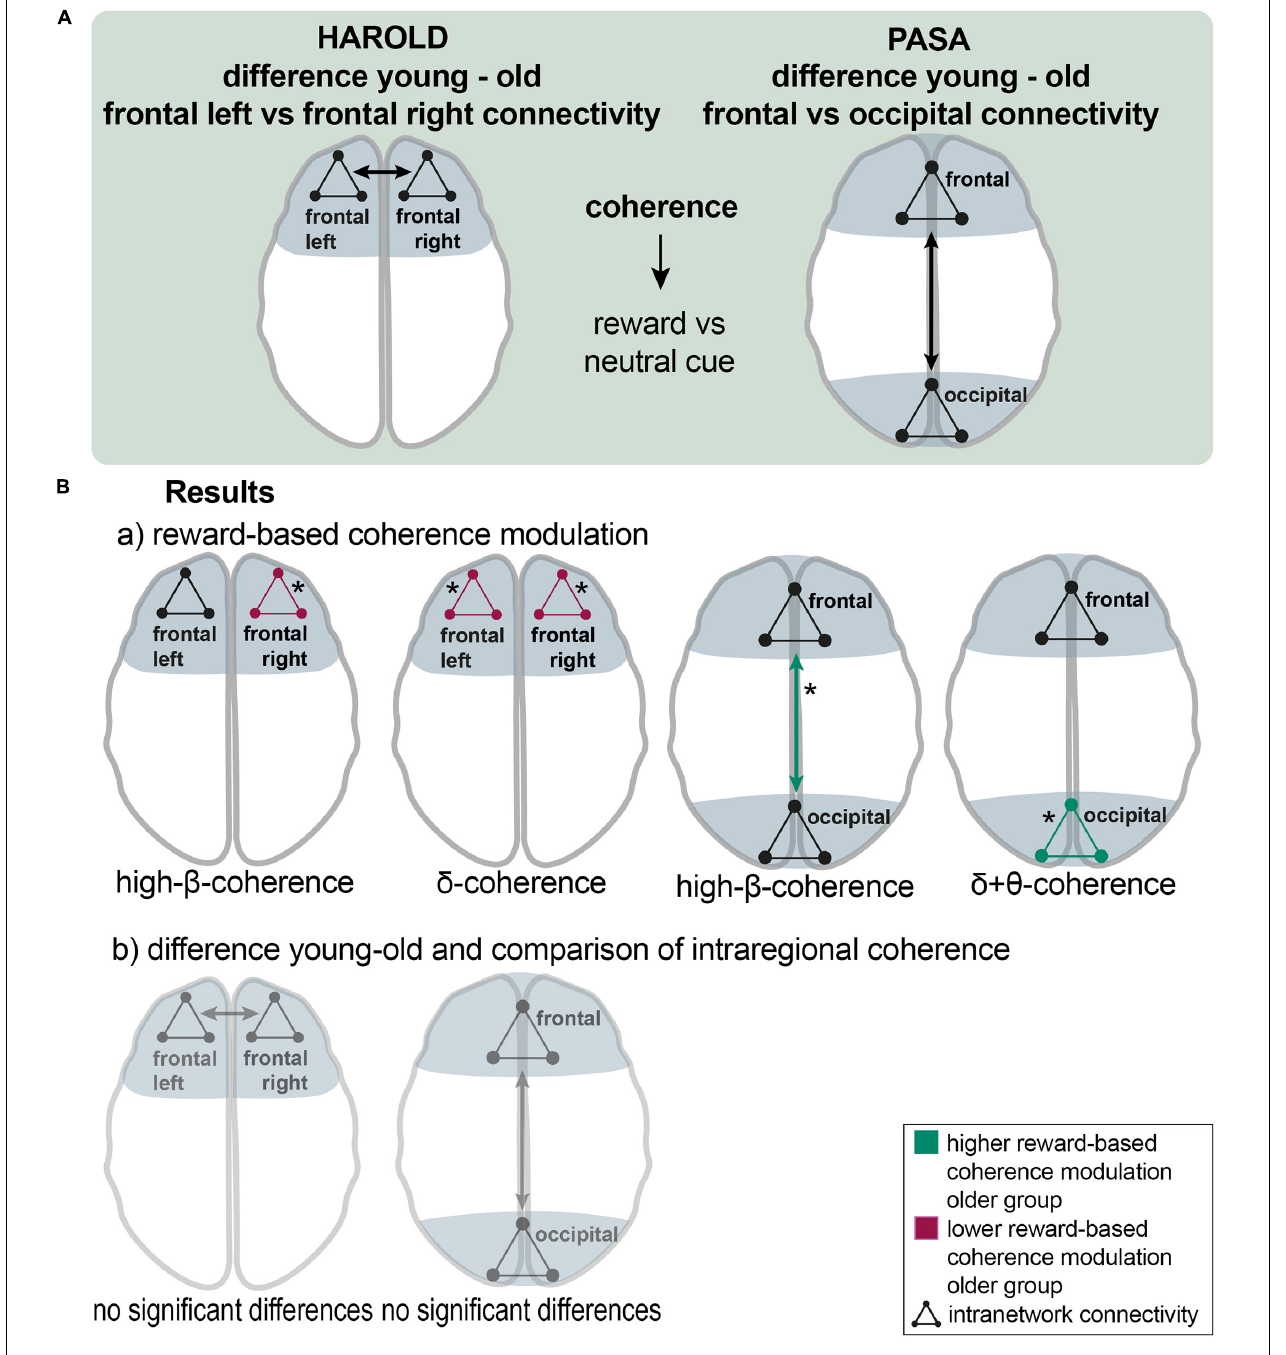
FIGURE 5 | The HAROLD and PASA effect during reward processing: (A), a schematic overview of the analyzing procedure: Testing HAROLD (left side), group differences in coherence between frontal left and frontal right channel groups were assessed for the reward vs. neutral cue contrast. Testing PASA (right side), group differences in coherence between frontal and occipital channel groups were assessed for the reward vs. neutral cue contrast. (B), Results: a) HAROLD in the delta band, the older group exhibited lower reward-based coherence modulation within the left frontal and the right frontal channel groups. In the high-beta band, the older group showed lower differences in coherence within the right frontal channel group than the younger group (red arrows). PASA - the difference between conditions was greater in the older compared to the younger group for coherence among occipital channel groups in the delta band and in the theta band. In the high-beta band, the older group exhibited a significantly higher reward-based modulation in coherence between frontal and occipital groups (green arrows). b) HAROLD - to investigate hemispheric asymmetry, the difference in reward-based coherence modulation of the frontal left and the frontal right channels was compared between the older and the younger groups, revealing no significant results. PASA - comparing the difference in reward-based modulation of frontal and occipital coherence between groups, no significant results appeared. Asterisks: one asterisk: p ≤ 0.05.